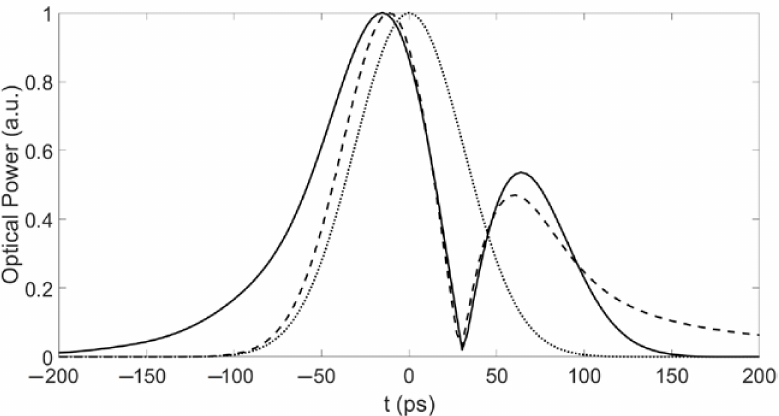
Figure 9. Ideal 0.51th-order differentiator (dashed curve) and simulated 0.55th-order differentiator (solid curve) time response. The input signal is also displayed (dotted curve); all signals were normalized to